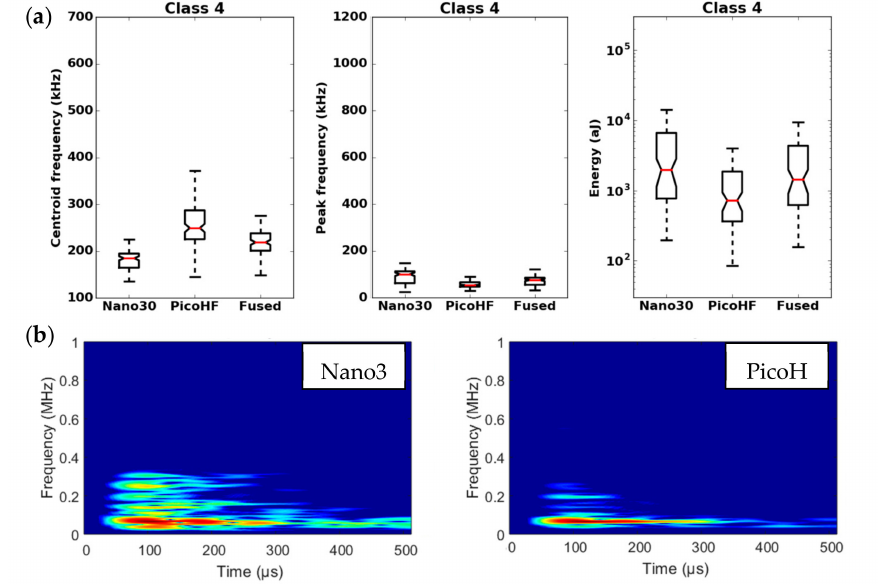
Figure 20. Results of the classification with an unsupervised classification based on fused features. ( a ) Characteristics of class 4 (frequency centroid, peak frequency and energy) viewed by the Nano30 sensor, PicoHF or with merged descriptors. ( b ) Representation in time / frequency domain with the SPWVD of the same AE signal recorded by Nano30 sensor and PicoHF sensor for class